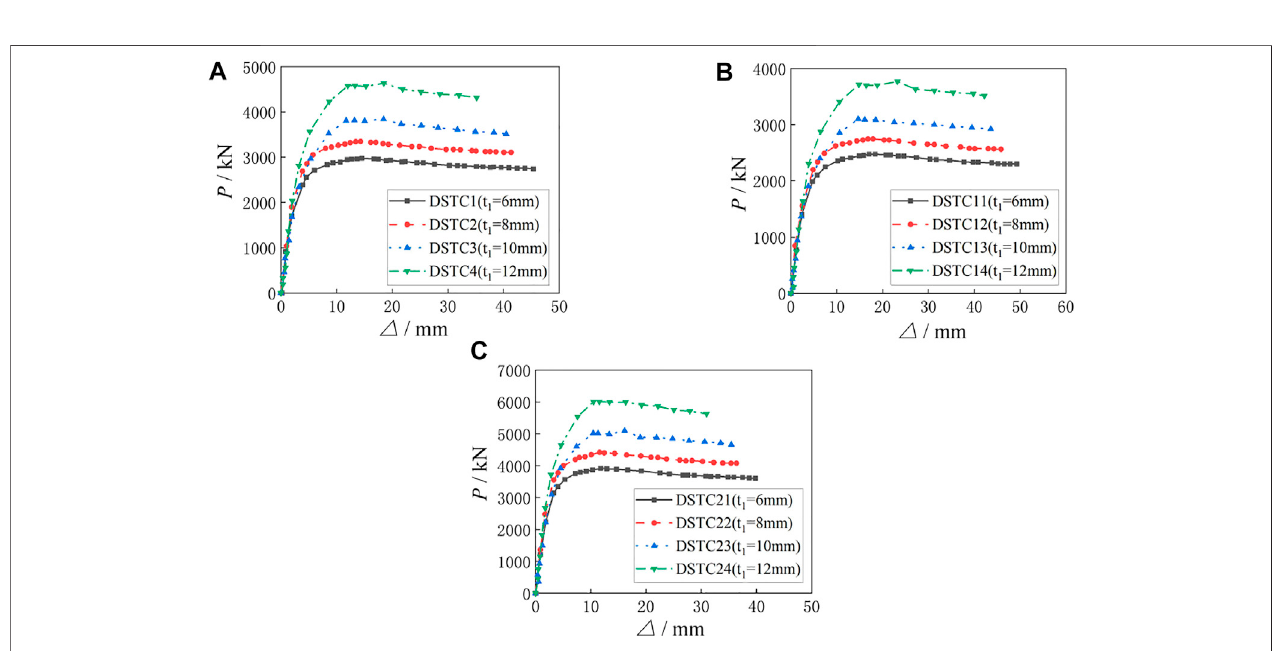
FIGURE 9 | Comparisons of load-displacement curves for specimens with different GFRP thicknesses. (A) Load-displacement curves of group A specimens. (B) Load-displacement curves of group B specimens. (C) Load-displacement curves of group C specimens.